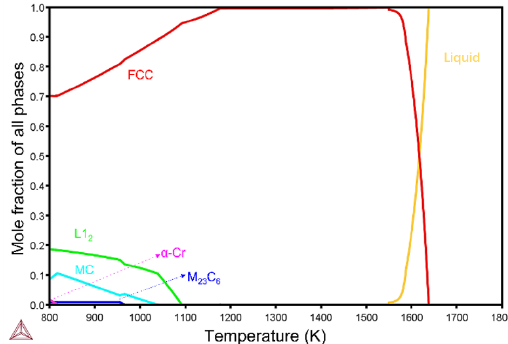
Figure 1. The calculated equilibrium phase diagram of the Ni-Fe-based alloy using Thermo-Calc software.